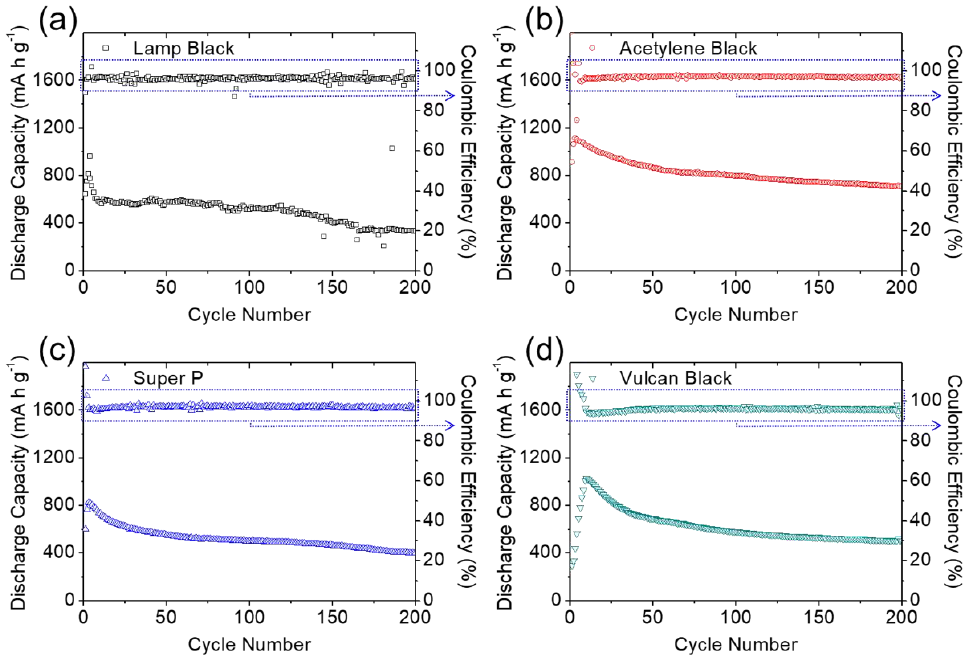
Figure 5. Electrochemical analysis: long-term cyclability of the high-loading sulfur cathode in the lean-electrolyte cells with different carbon coating modules of ( a ) lamp black, ( b ) acetylene black, ( c ) Super P, and ( d ) Vulcan black. Table 2. Electrochemical characteristics: cell performance of the high-loading sulfur cathode in the lean-electrolyte cells with different carbon coating